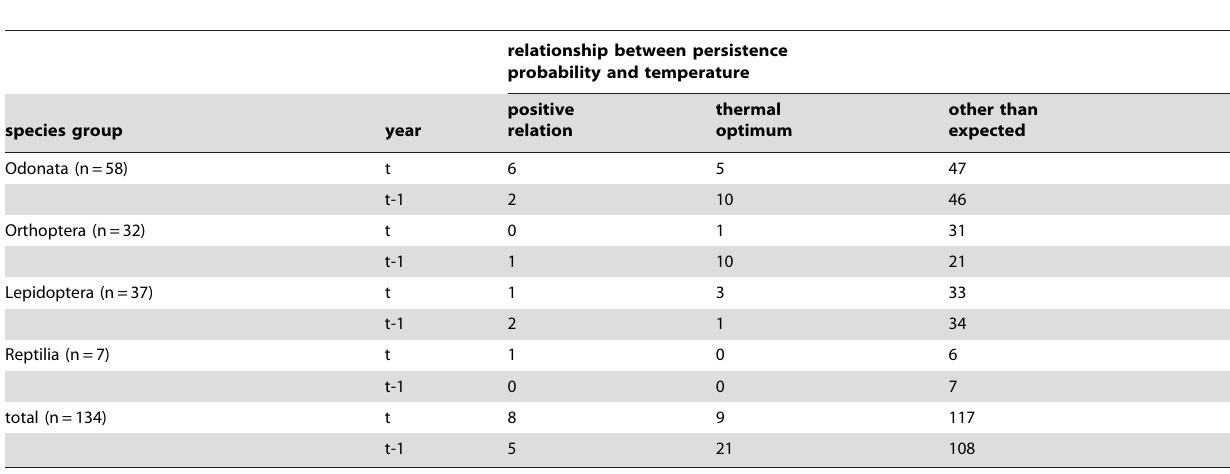
Table 3. Number of species by group that show given relationships between persistence probability and temperature in current or preceding